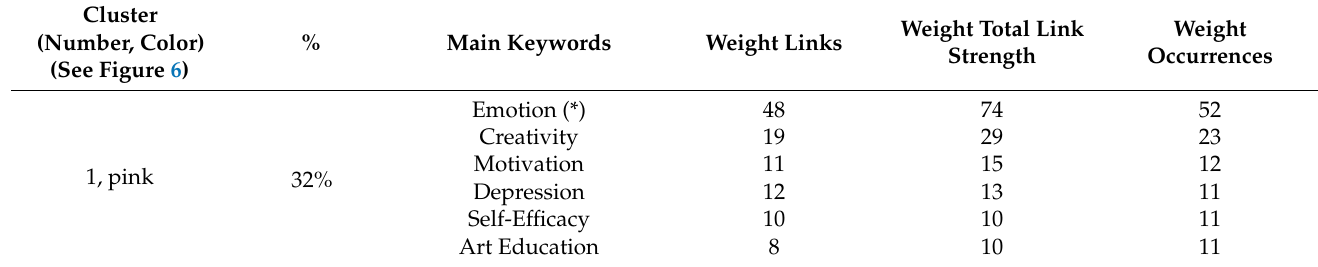
Table 3. Clusters of keywords (1917–2020).